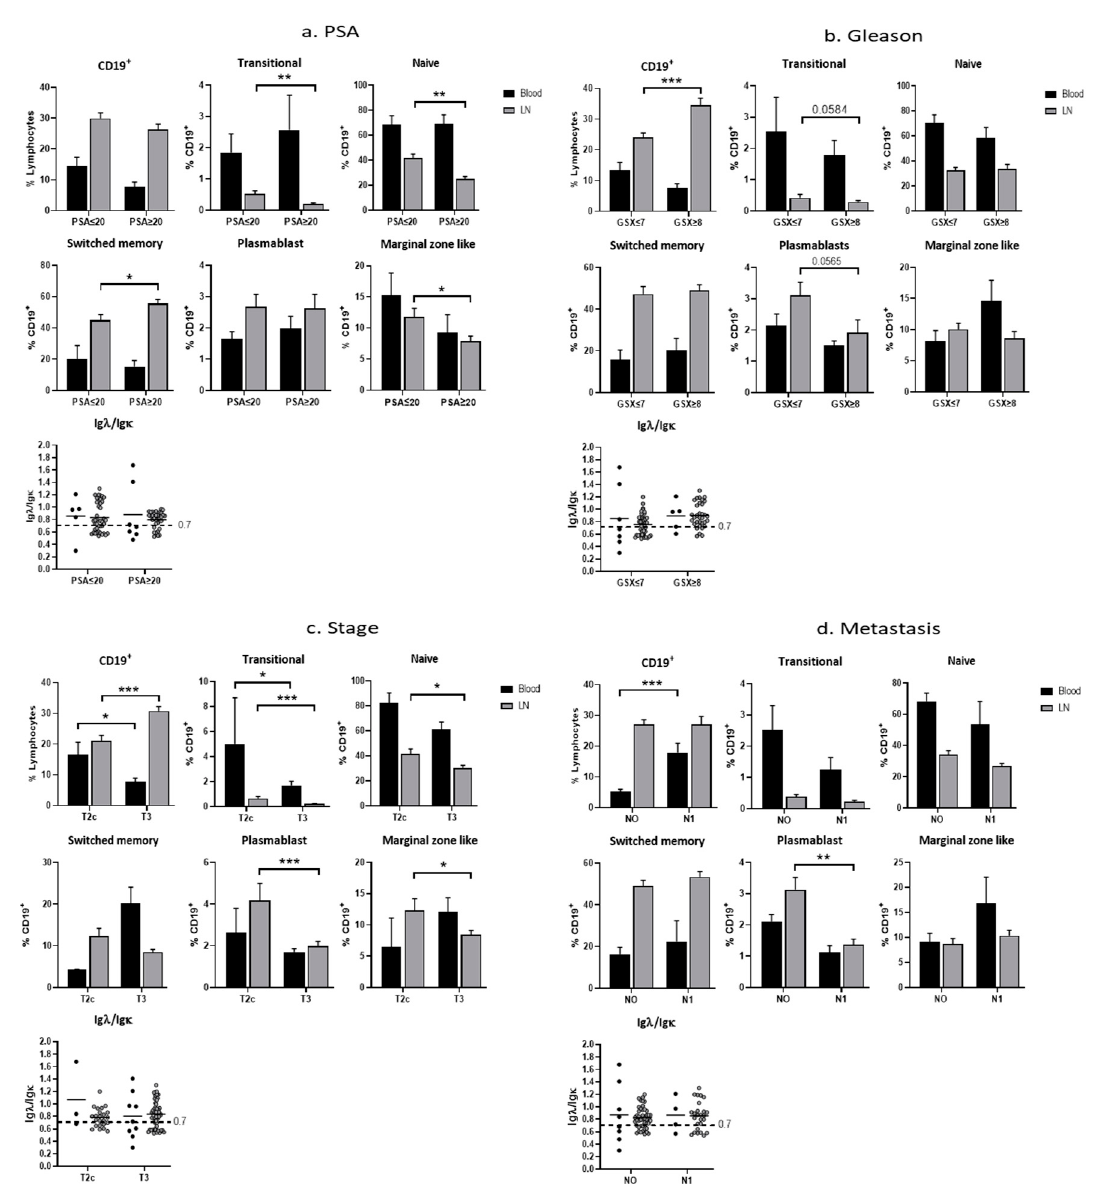
Figure 4. Correlation of clinical parameters and CD19 B cells in peripheral blood and lymph nodes of patients. Patients were stratified based on clinical parameters and analyzed for B-cell populations. Mean percentages of CD19 + B cells in total lymphocytes and of the B-cell subpopulations in CD19 + lymphocytes are shown. Dotted line marks the expected normal IgL/IgK ratio of 0.7. All error bars indicate SEM. Percentages of lymphocyte subpopulations were compared with the Student two-tailed t -test. p : * ≤ 0.05, ** ≤ 0.01 *** ≤